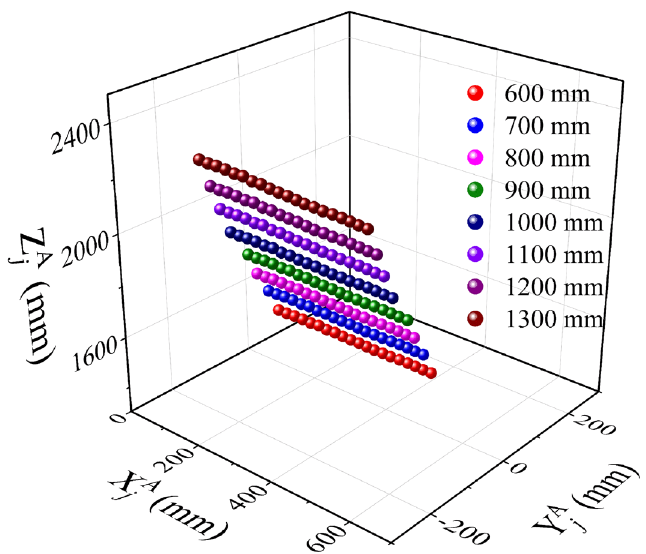
Figure 4. The reconstruction coordinates of the laser points on the chessboard pattern. The distance between the external camera and the cubic board is 600–1300 mm with 100 mm interval. The spatial coordinates of reconstruction points increase evenly with the growth of the distance from CSOB to